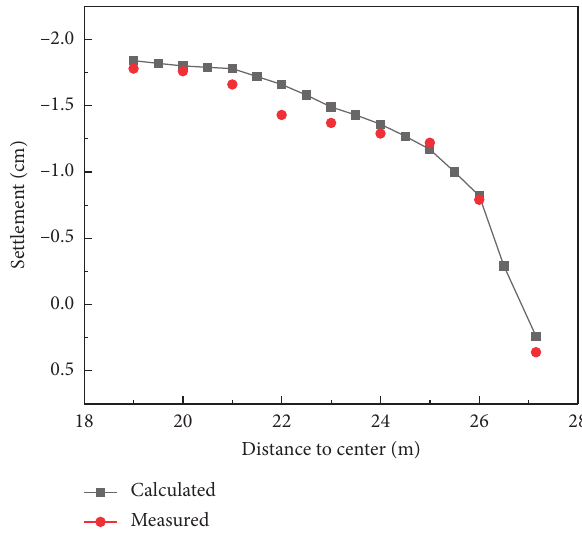
Figure 17: Calculated and measured settlement